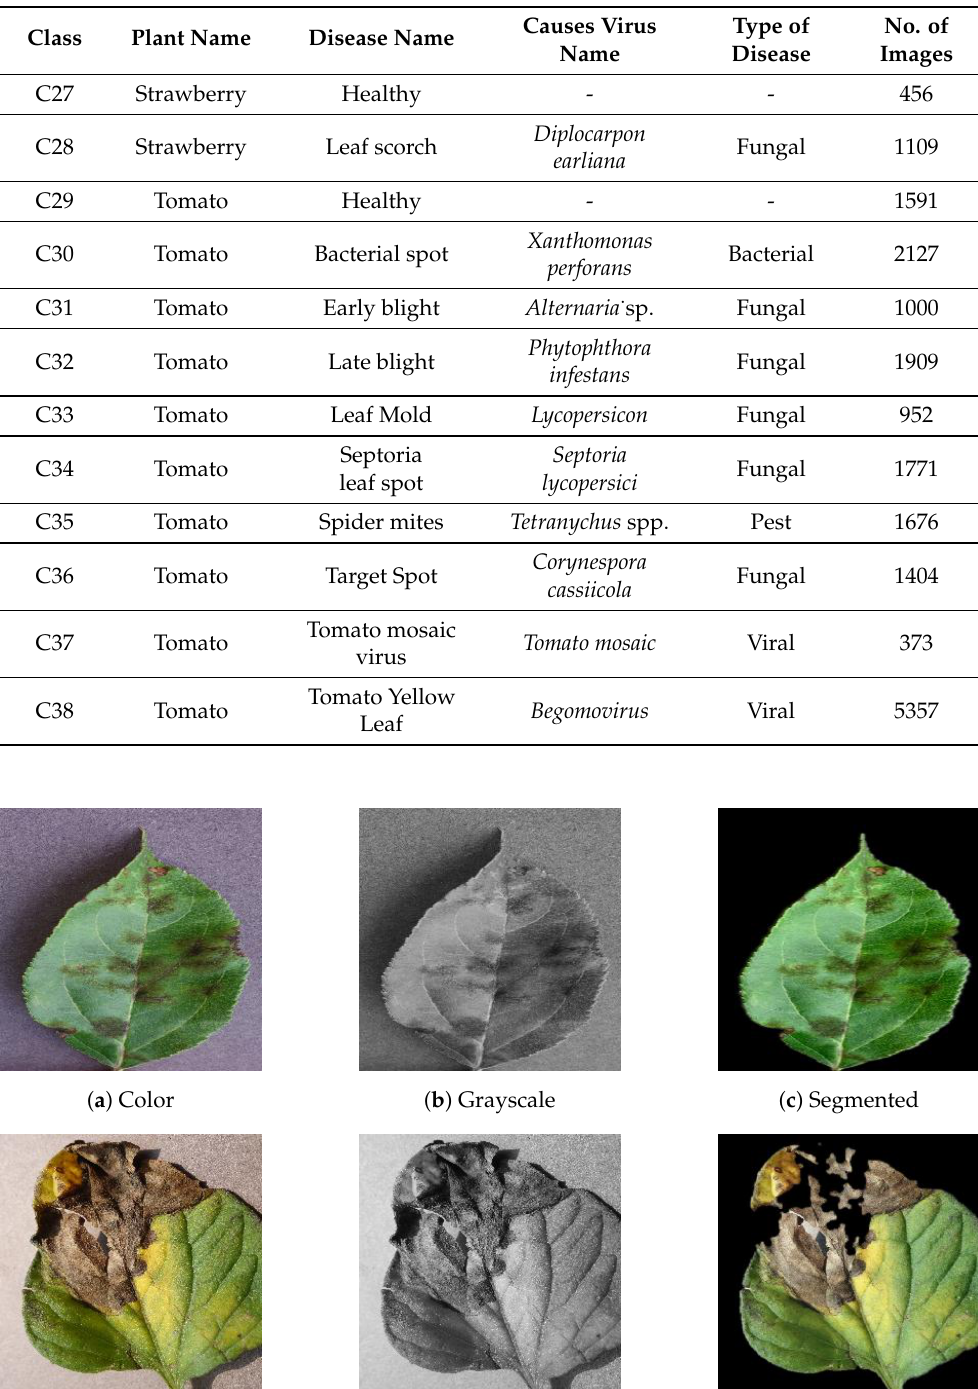
Table 6. Detailed description of PlantVillage Dataset with relative information.